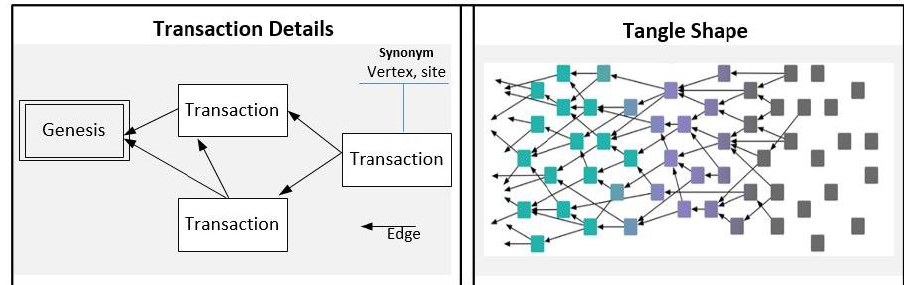
Figure 2. IOTA DAG